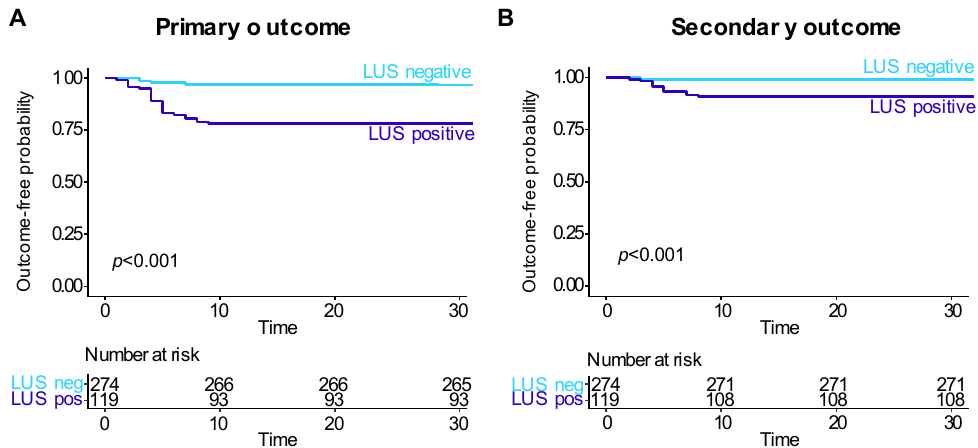
Figure 4. Kaplan–Meier curves for the ( A ) primary outcome and ( B ) secondary outcome in patients stratified by LUS results.